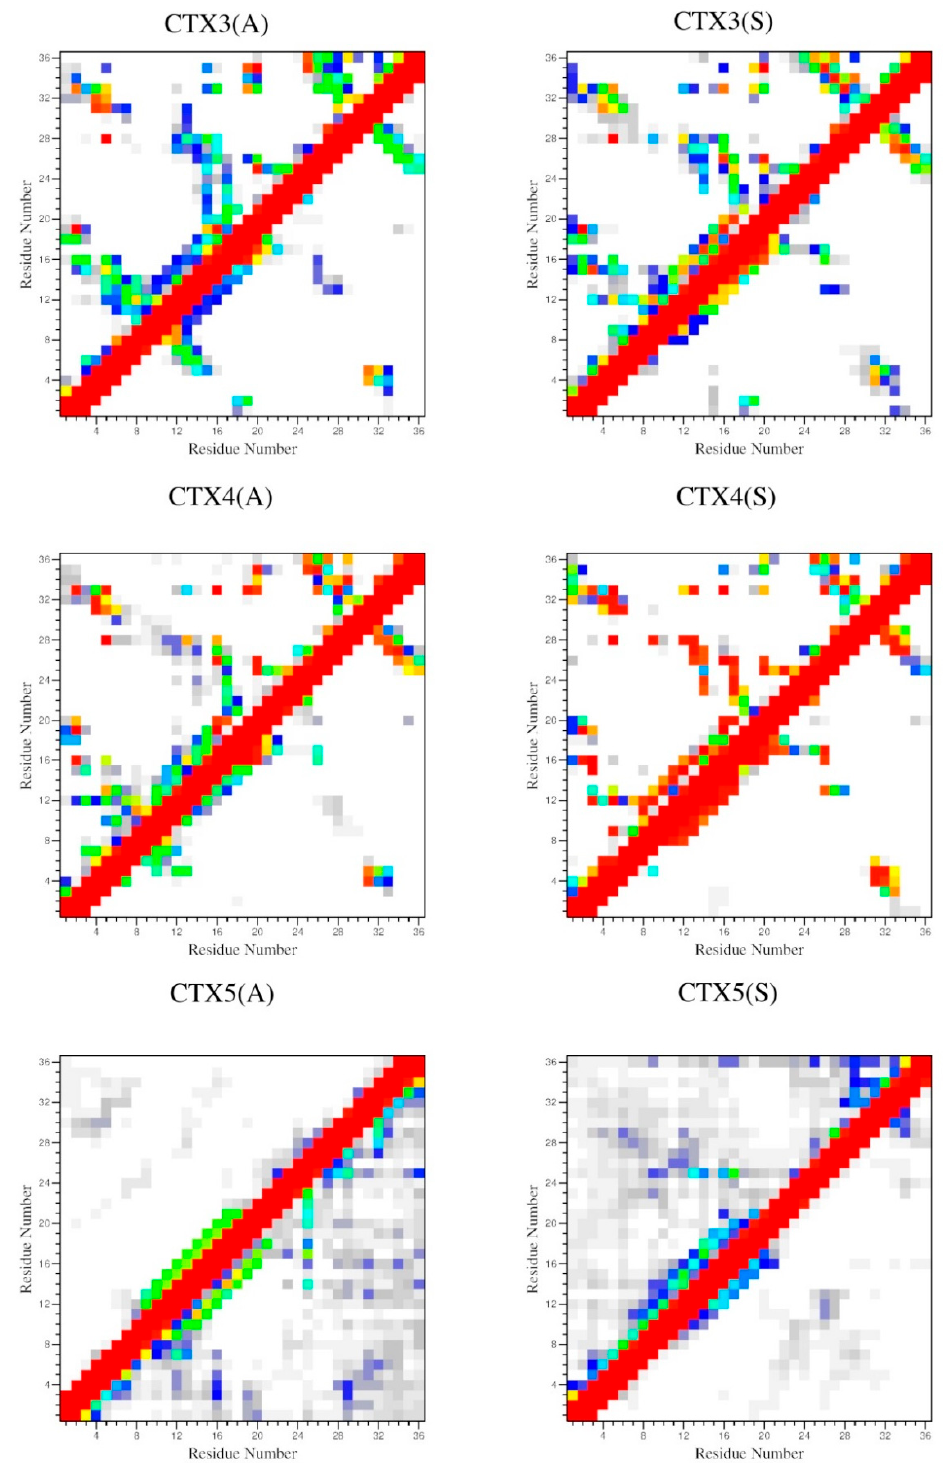
Figure 4. Probability maps for backbone–backbone contacts (below the diagonal) and sidechain–sidechain contacts (above the diagonal) as a function of residue number for CTX and its Abu- and Ser-substituted analogs. The color scale represents the relative probability of contact.